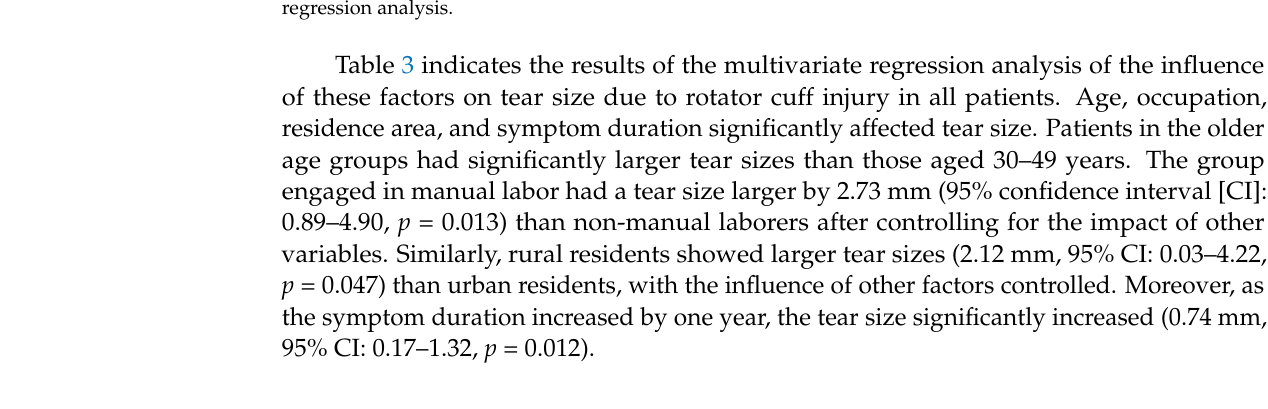
Table 3 indicates the results of the multivariate regression analysis of the influence of these factors on tear size due to rotator cuff injury in all patients. Age, occupation, residence area, and symptom duration significantly affected tear size. Patients in the older age groups had significantly larger tear sizes than those aged 30–49 years. The group engaged in manual labor had a tear size larger by 2.73 mm (95% confidence interval [CI]: 0.89–4.90, p = 0.013) than non-manual laborers after controlling for the impact of